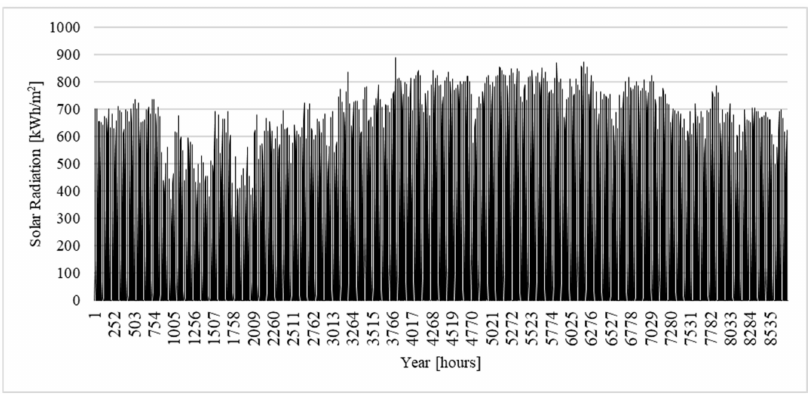
Figure A5. Hourly direct solar radiation in the year 2019 at the model based on data from